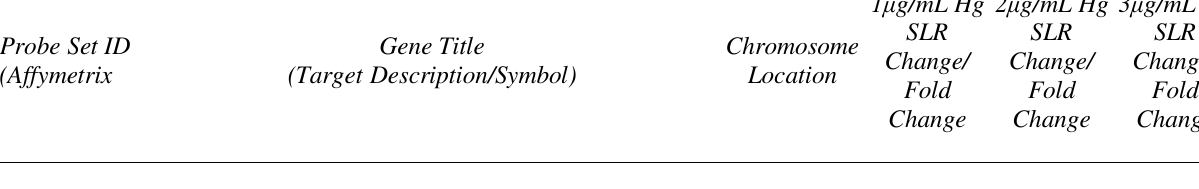
Table 1 contd.: Sample genes affected by mercury. Probe Set